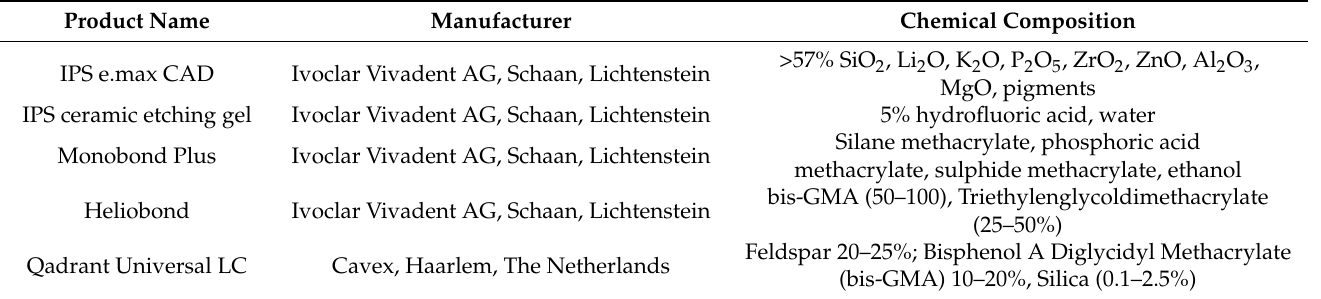
Table 1. Product names, manufacturers, and the respective chemical compositions of study